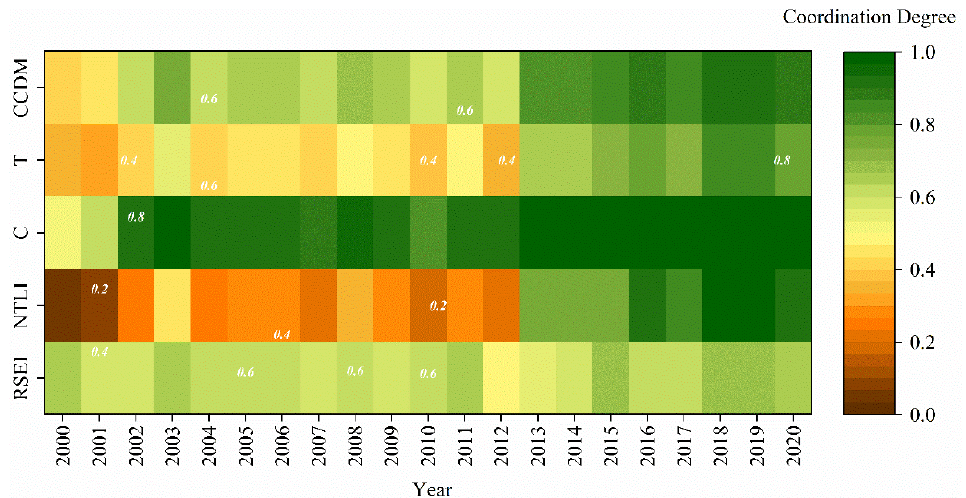
Figure 7. Interannual variation in urban ecological indicators.